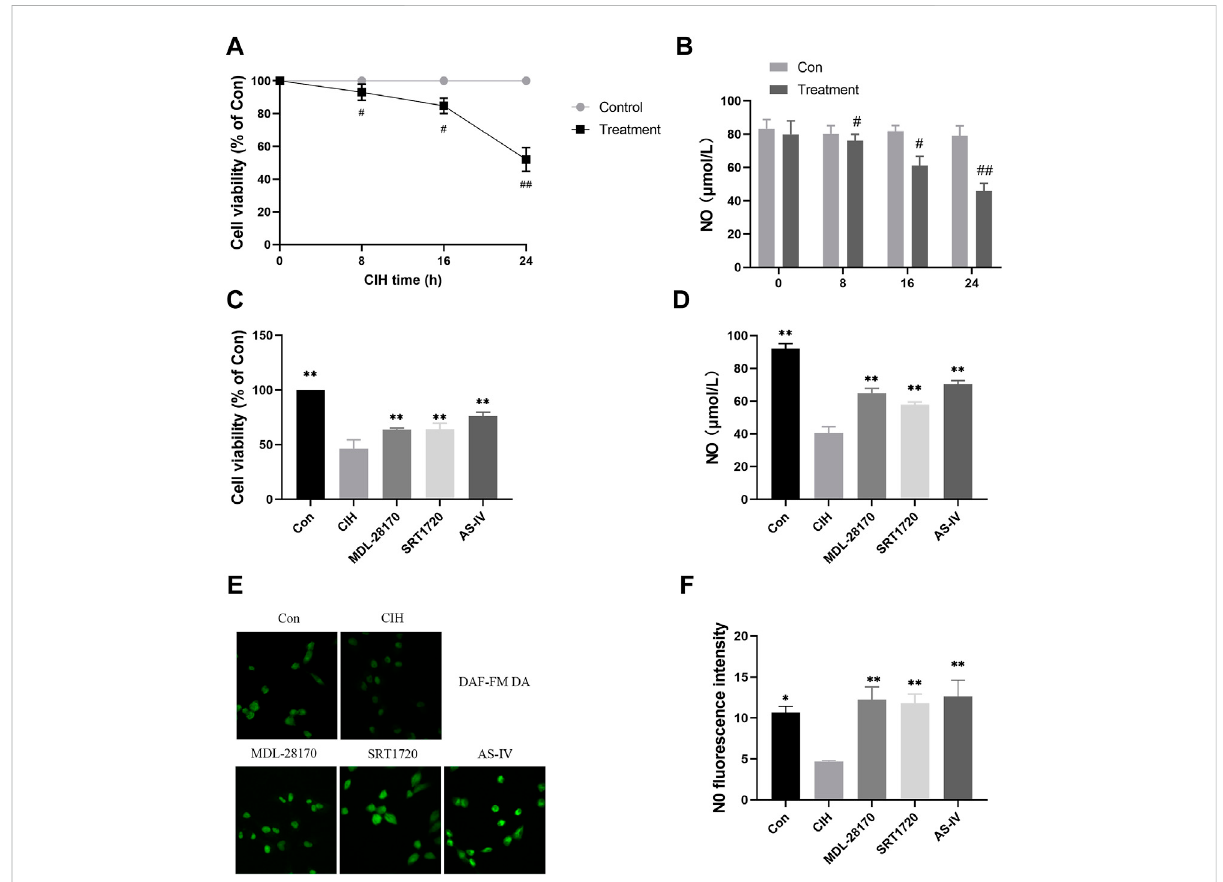
FIGURE 5 EffectsofAs-IV,MDL-28170andSRT1720onHCAECviabilityandtheproductionofNO. (A) CellviabilityofHCAECssubjectedtoCIH(1%O 2 for 5 min – 20% O 2 for 5 min) at the indicated times at the indicated times ( n = 5). (B) NO level in HCAEC supernatant subjected to CIH at the indicated times ( n = 8). (C) Cell viability of HCAECs in different groups ( n = 5). (D) NO levels in HCAEC supernatants from different groups (n = 8). (E,F) Representative images and fl uorescence intensity of NO in HCAECs of different groups (×200 magni fi cation; n = 3). DAF-FM DA dye (green). Data are presented as means ± SD. ## p < 0.01, # P ＜ 0.05, vs. Con group, ** p < 0.01, *P ＜ 0.05, vs. CIH